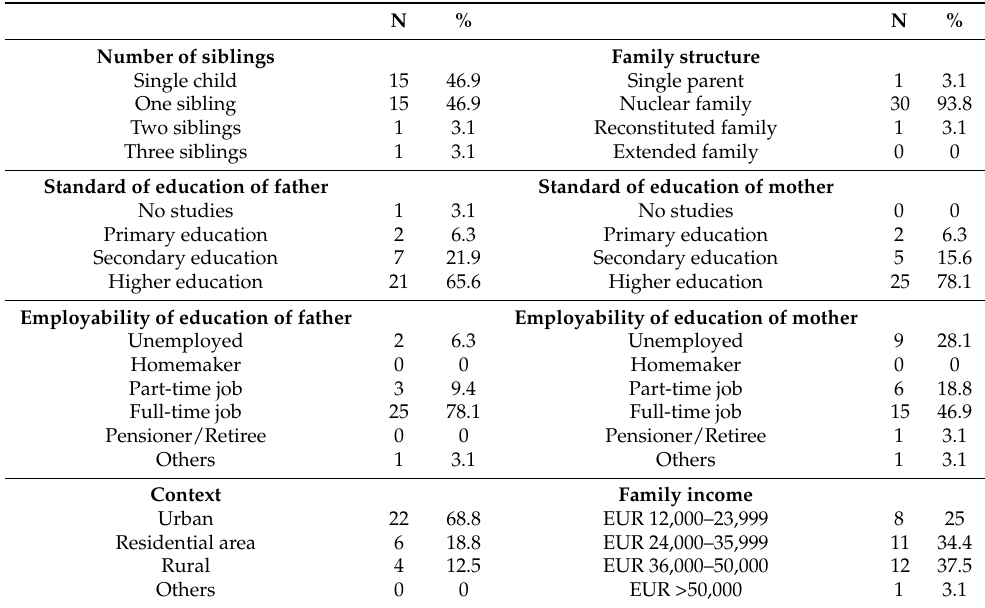
Table 1. Characteristics of the participants and their